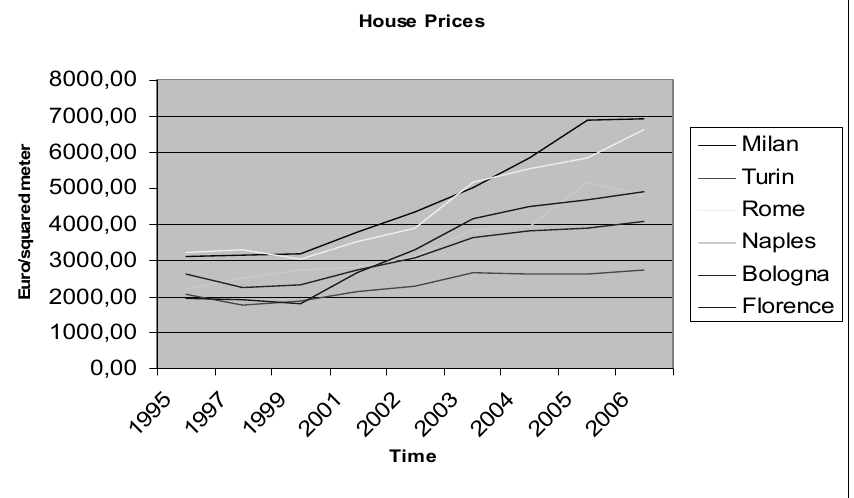
Figure 5a – House Prices; our elaboration based on data drawn from “Il Consulente Immobiliare”.